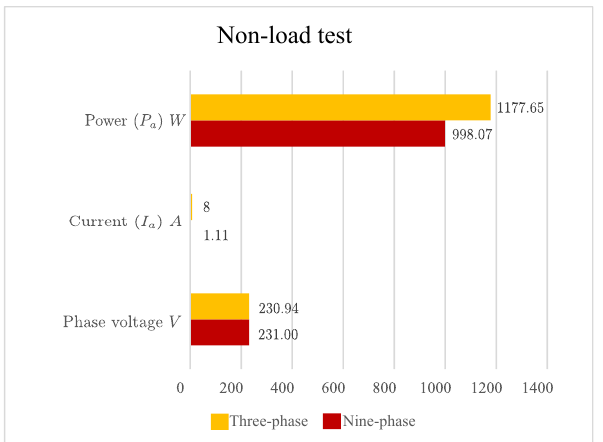
Figure 15. Comparison between the obtained values using the non-load test applied to the three-phase and nine-phase IM.